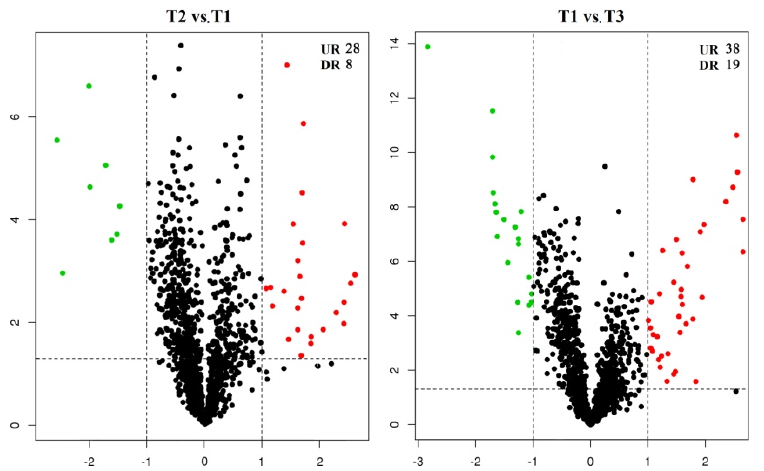
Figure 2. Volcano plot for roots of Vitis riparia × Vitis labrusca and Cabernet Sauvignon with different treatments. T1: V. riparia × V. labrusca at − 4 °C ; T2: V. riparia × V. labrusca at − 15 °C; T3: Cabernet Sauvignon at − 4 °C. UR, upregulated; DR, downregulated.